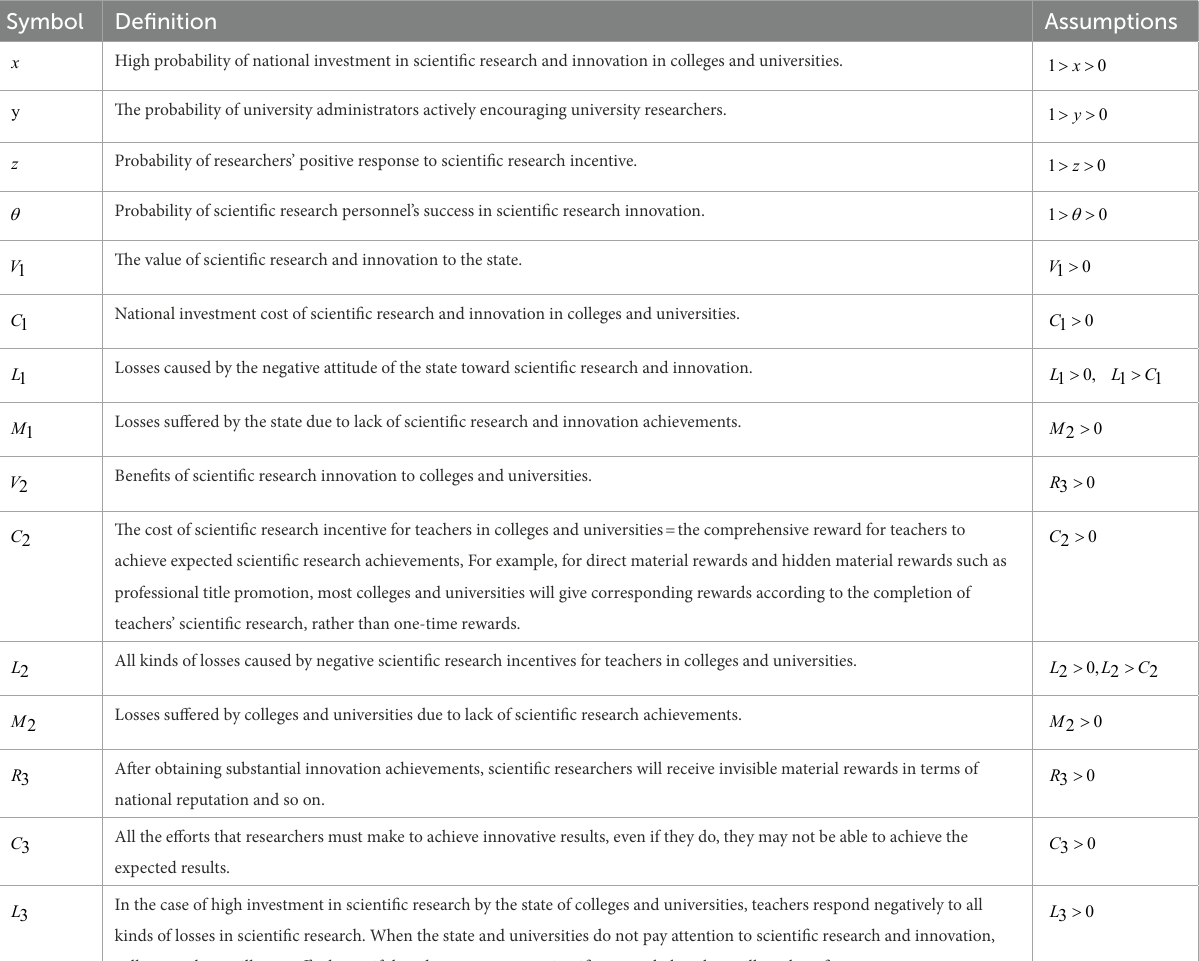
TABLE 1 Definition and assumptions of the variables and relative